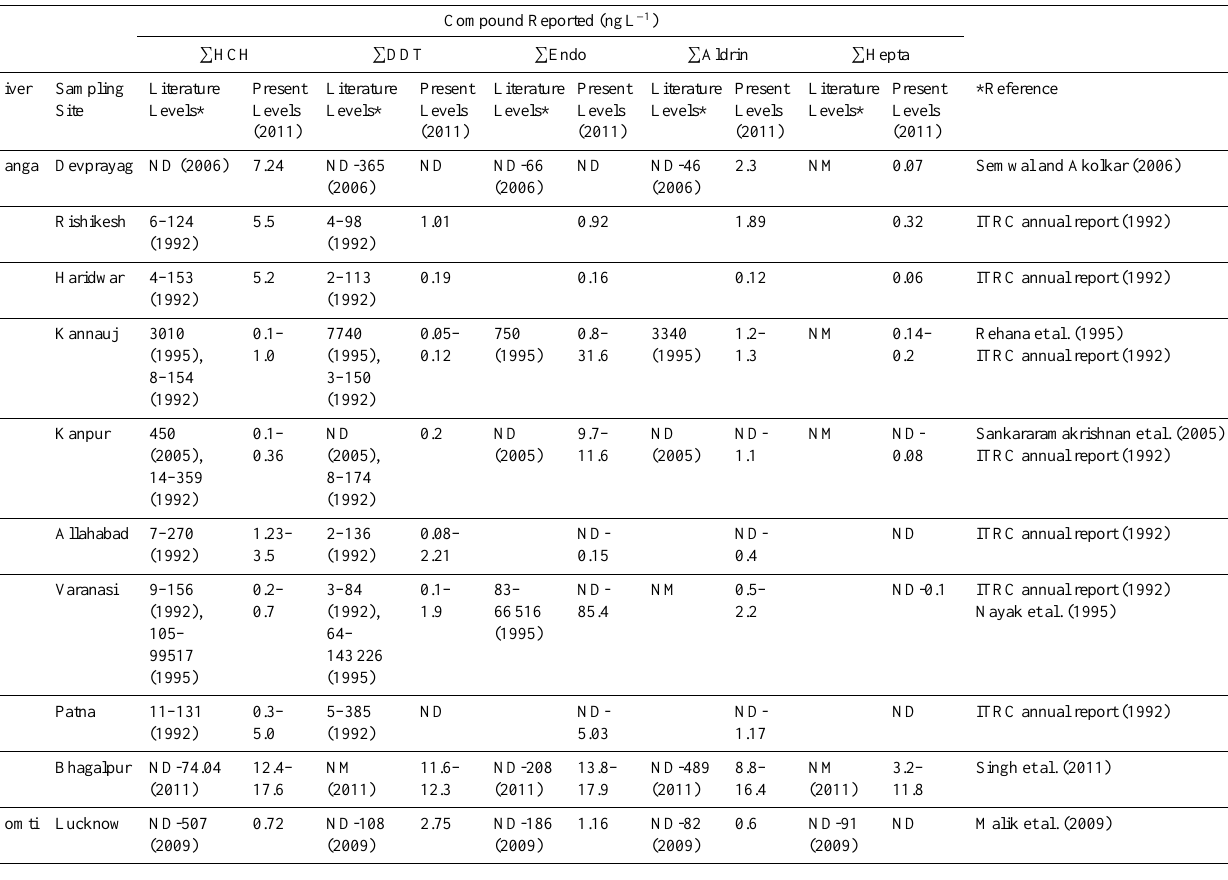
Table 5. Comparison of reported OCPs levels in rivers of Ganga Basin to the present study at di ff erent locations.